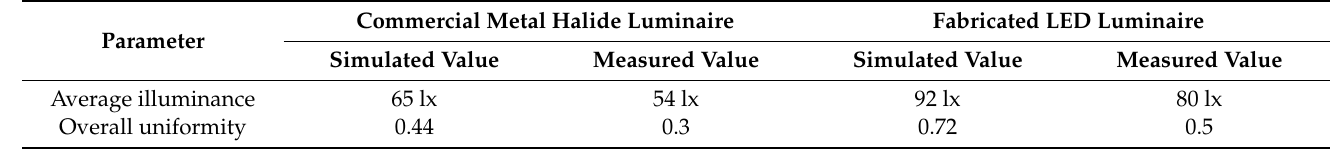
Table 6. Simulated and measured overall